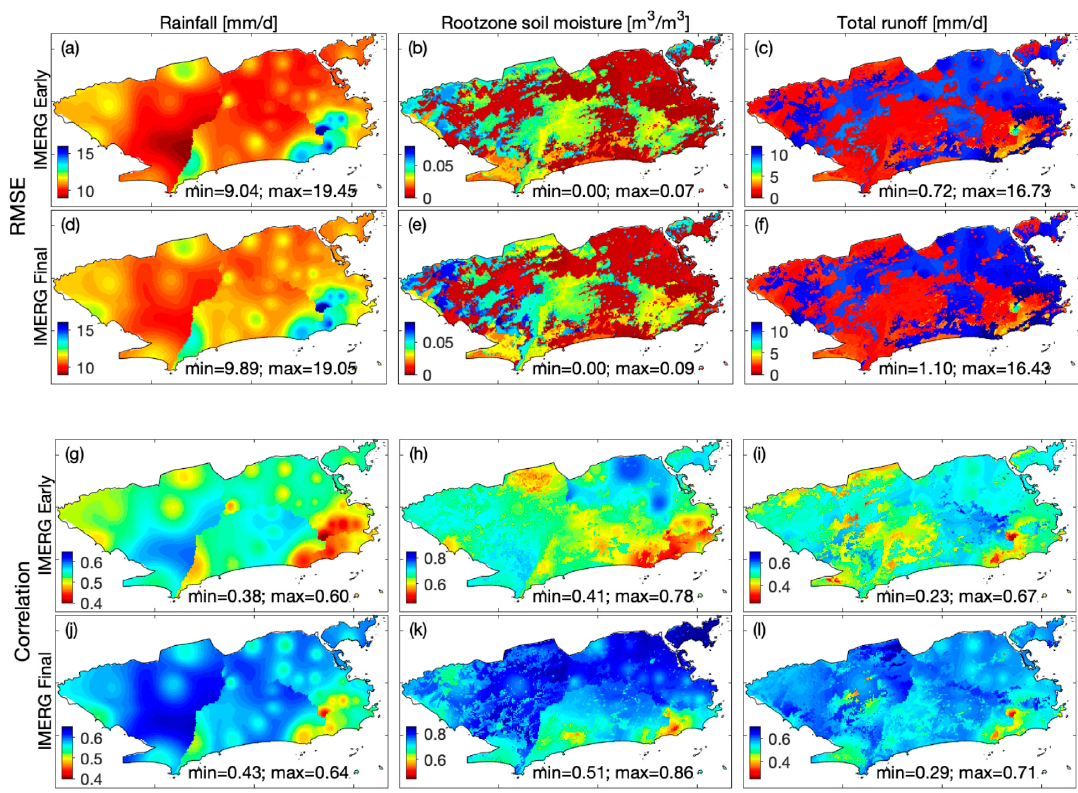
Figure 5. Spatially distributed RMSE and correlation of absolute rainfall, rootzone soil moisture and total runoff estimates over 2001–2019 wet seasons. Results are shown for experiments with IMERG